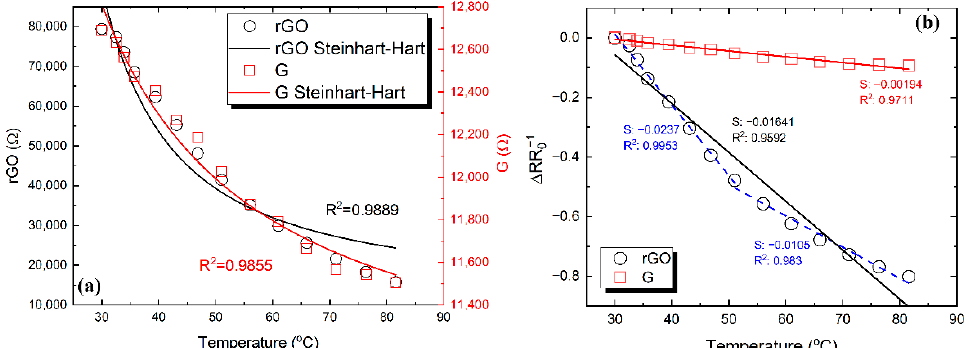
Figure 11. Temperature–resistance relationship for the graphene and f ‐ rGO printed samples. R(T) curves for both samples alongside fitting using the Steinhart–Hart equation ( a ); relative resistance change with temperature and linear fitting lines ( b ).